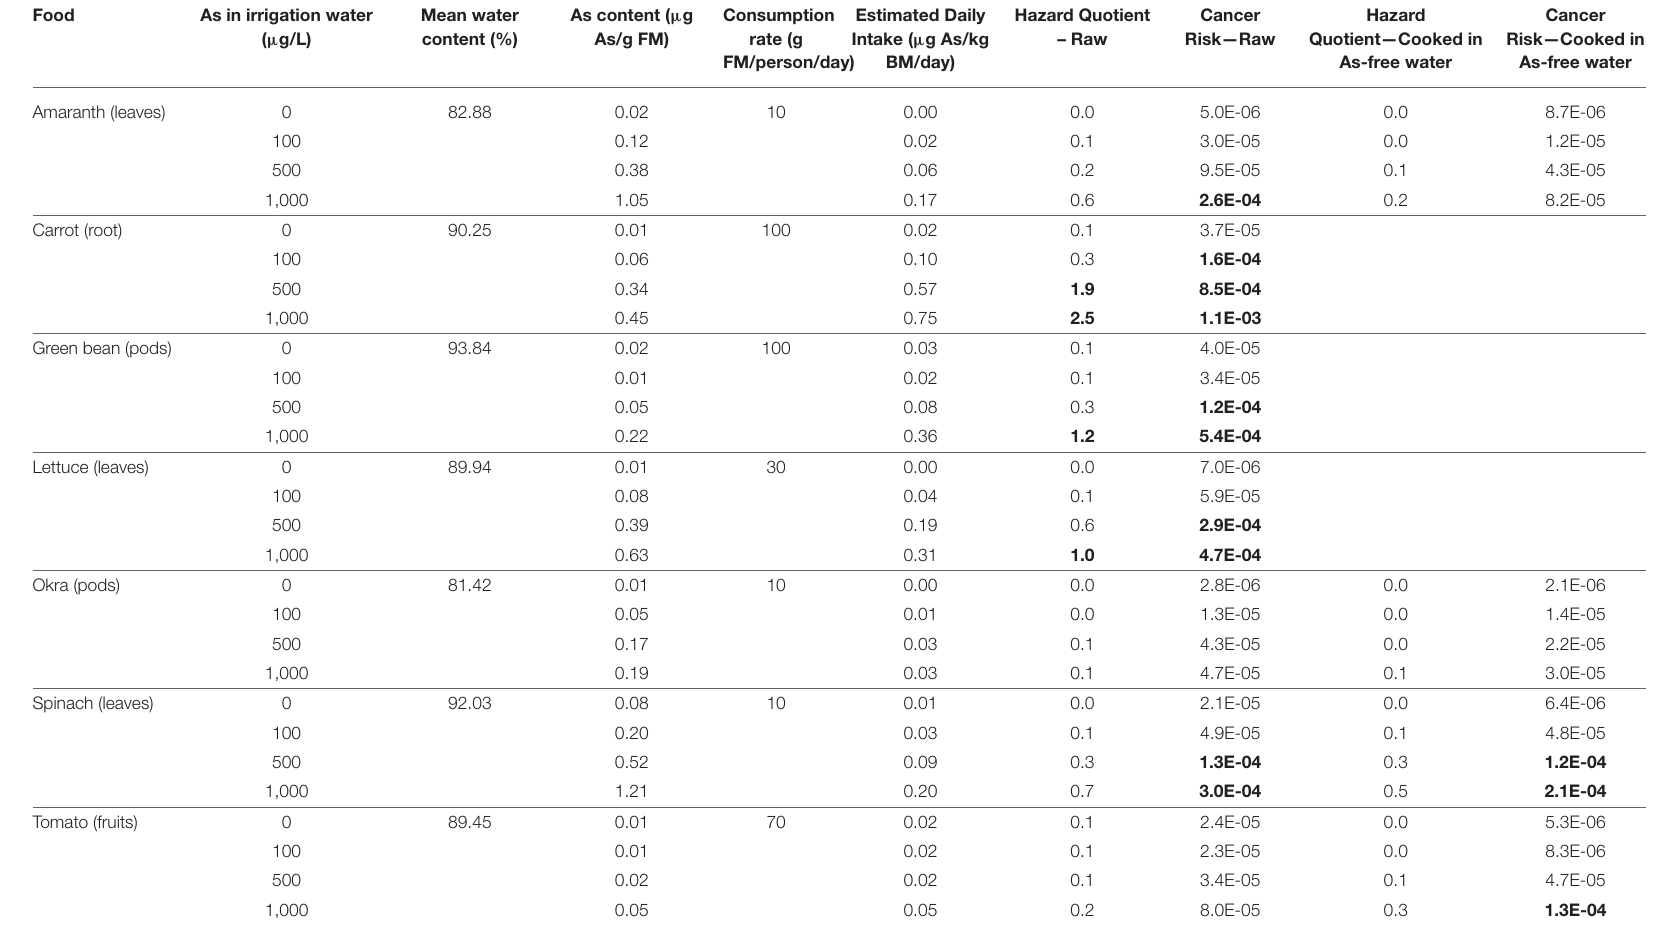
Cancer Hazard Quotient Cancer Hazard Estimated Daily Mean water As content ( µ g Consumption Risk—Cooked in – Raw Risk—Raw Quotient—Cooked in Intake ( µ g As/kg ( µ g/L) content (%) As/g FM) rate (g As-free water As-free water BM/day) FM/person/day)